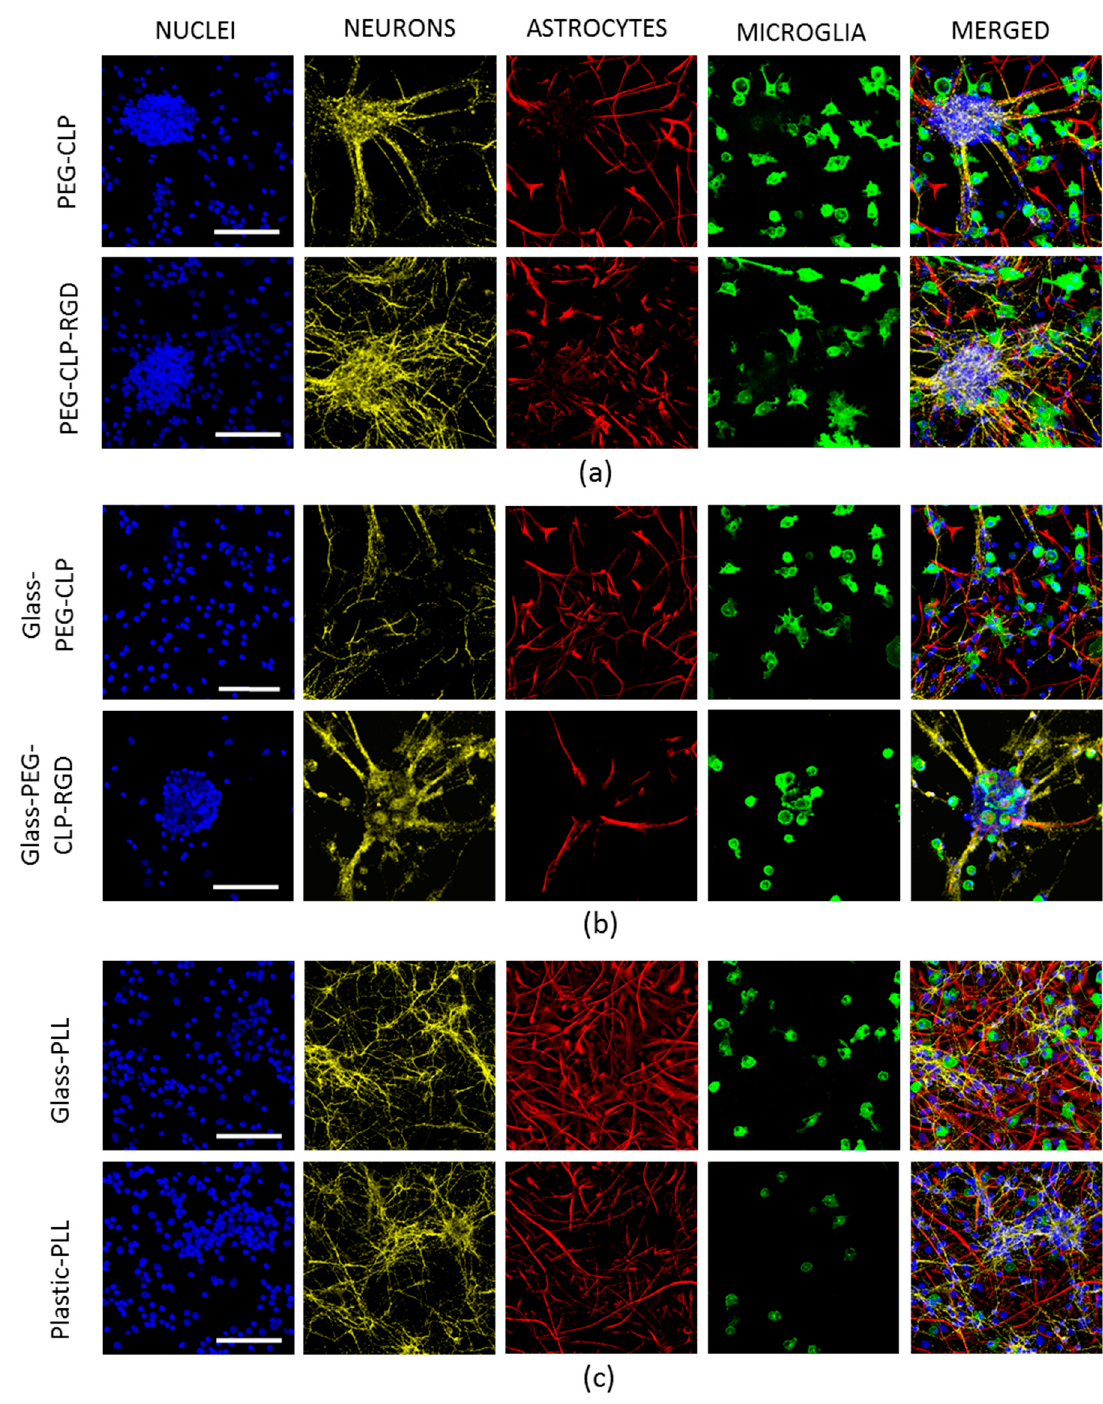
Figure 4. Confocal images of cerebellar neuronal-glial cell cultures after seven days in vitro (DIV7) on PEG-CLP and PEG-CLP-RGD hydrogel membranes ( a ), on glass coated with PEG-CLP and PEG-CLP-RGD conjugates ( b ), and on poly-L-lysine-coated glass and plastic ( c ). All nuclei were stained blue with Hoechst33342; neurons (yellow) are immunolabelled for microtubule-associated protein 2 (MAP-2), astrocytes (red) are immunolabelled for glial fibrillary acidic protein (GFAP), and microglia are stained green with isolectin GS-IB4. Scale bar is 100 µm. Total cell numbers were nearly twice as lower on the PEG-CLP hydrogels and by one third lower on PEG-CLP-RGD hydrogels compared to poly-L-lysine-coated glass and plastic cultures (Figure 5a).